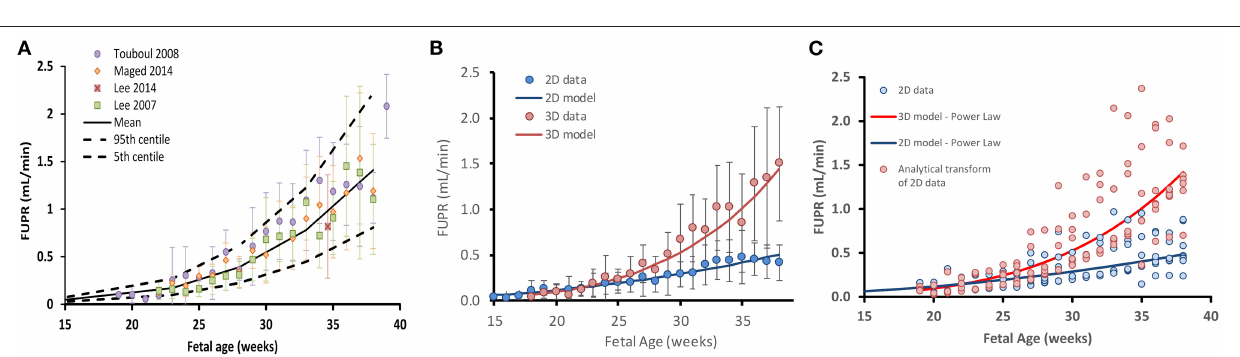
FIGURE 2 | Fetal urine production rate (FUPR) during development. (A) FUPR as a function of fetal age (weeks). Colored filled circles are mean observations from 3D ultrasound data and error bars represent the standard deviation (SD). Solid black lines are predicted mean FUPR (From power law regression model, Equation 4) and dashed black lines represent the 5th and 95th percentiles for the observed data. (B) Observed mean 3D (red) and 2D (blue) ultrasound data. Each point is a weighted mean and standard deviation (bars), weighted by the number of subjects at each week. Power law regression models for each methodology are shown in solid lines. (C) Effect of transforming FUPR, as measured by 2D ultrasound (blue open circles). Summary data for every study plotted separately rather than averaged (as in the case in B ). Resultant transformed data points (red open circles using Equation 7). Blue solid line: 2D power law regression model (Equation 5). Red solid line: 3D power law regression model (Equation